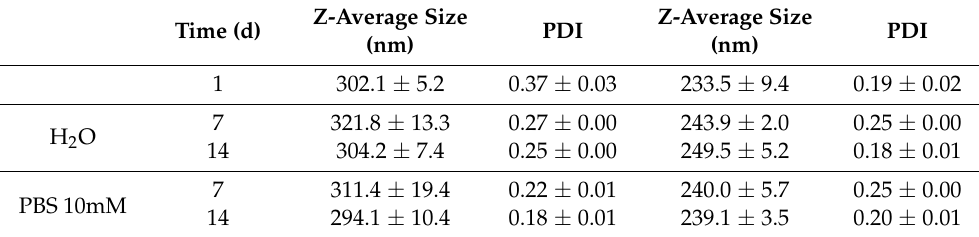
Figure 2. Evaluation of size, morphology, ζ -potential and PDI of PENs by different techniques which exhibit SEM micrographs of APENs ( a ); RIF/APENs ( b ); WPENs ( c ); and RIF/WPENs ( d ). TEM images of APENs ( a’ ); RIF/APENs ( b’ ); WPENs ( c’ ); and RIF/WPENs ( d’ ); and DLS analyses ( e ). Table 2. Physicochemical characterization of PENs during two